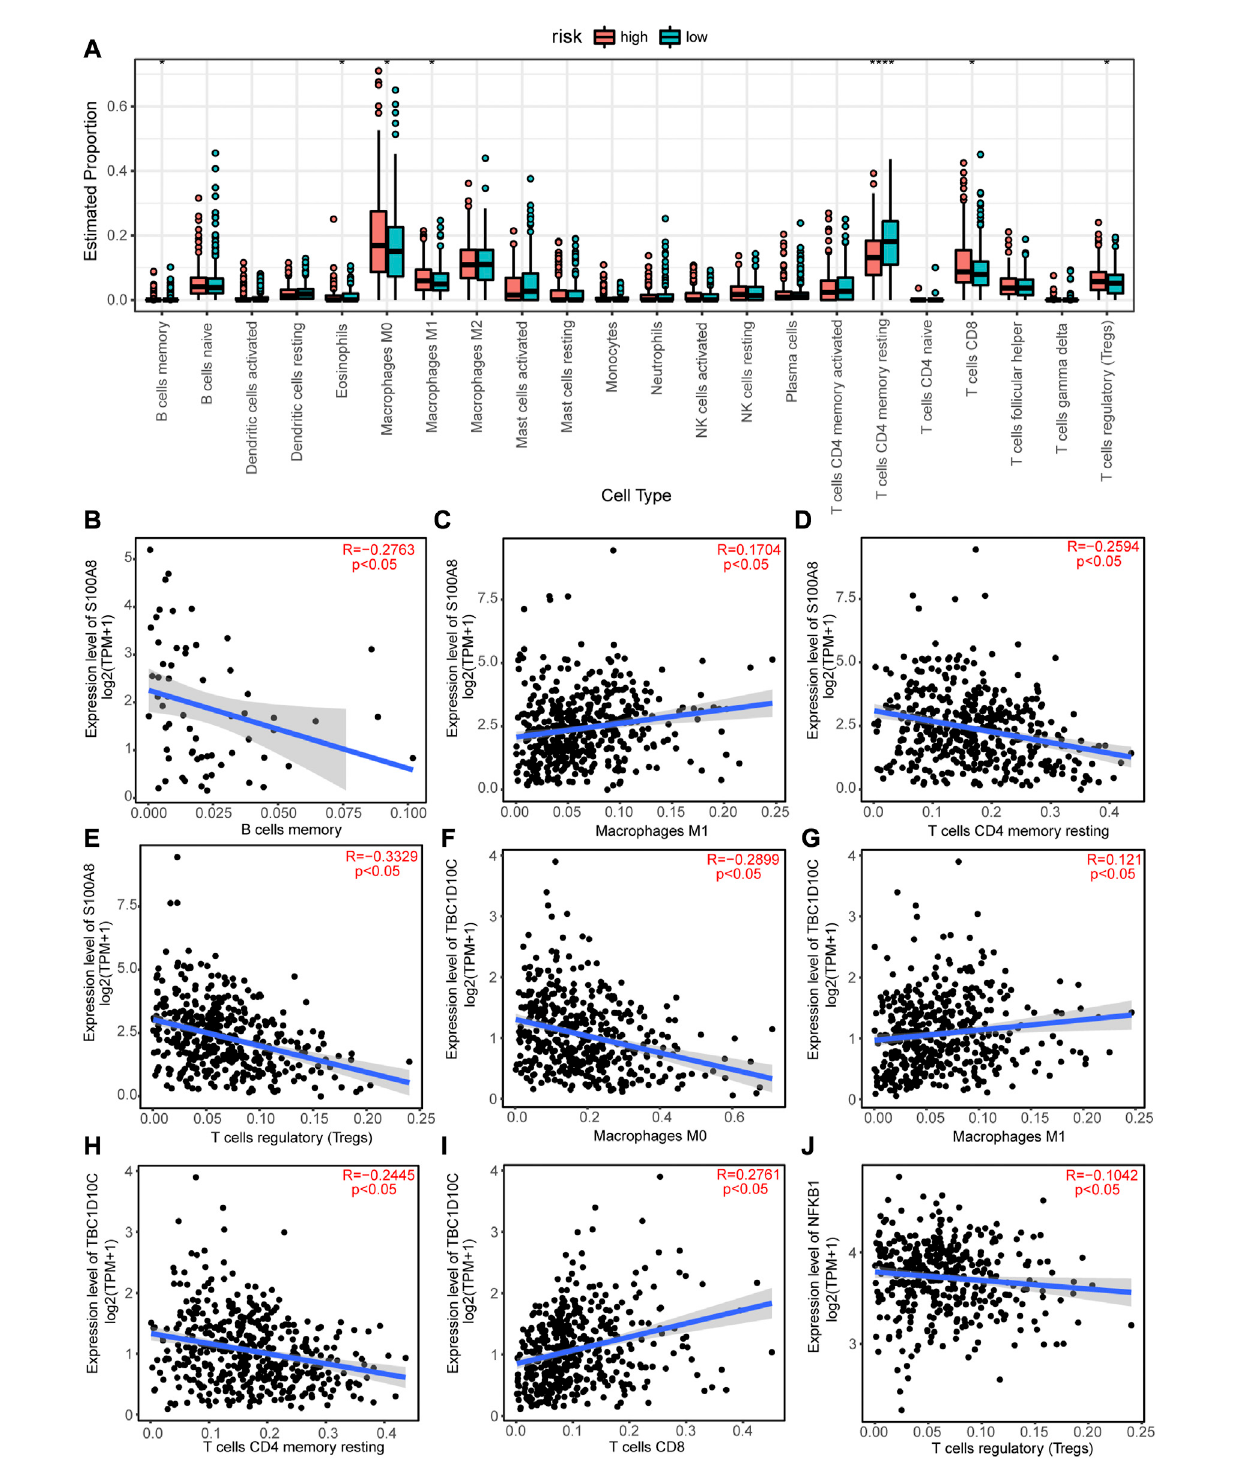
FIGURE 9 Immune in fi ltration analysis of the high-risk and low-risk groups and correlations between autophagy-related genes (ARGs) expression levels and immunecellin fi ltrations. (A) Differencesinimmunecellin fi ltrationsbetweenthehigh-riskandlow-riskgroups.* p < 0.05;** p < 0.01;*** p < 0.001;**** p < 0.0001. (C) S100A8 expression level positively correlated with macrophage M1 cell in fi ltration, but negatively correlated with (B) B cells memory cell in fi ltration, (D) T cells CD4 memory resting cell in fi ltration, and (E) T cells regulatory (Tregs) cell in fi ltration. TBC1D10C expression level is positively correlated with (G) Macrophages M1 and (I) T cells CD8 cell in fi ltration8, but negatively correlated with (F) Macrophages M0 and (H) T cells CD4 memory resting cell in fi ltration. (J) NFKB1 expression level negatively correlated with Treg cell in fi